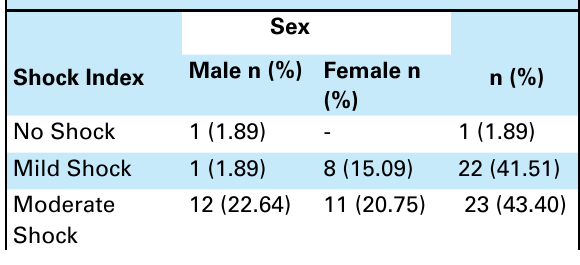
Table 3. Categorization of male and female patients in shock based on shock index (n=